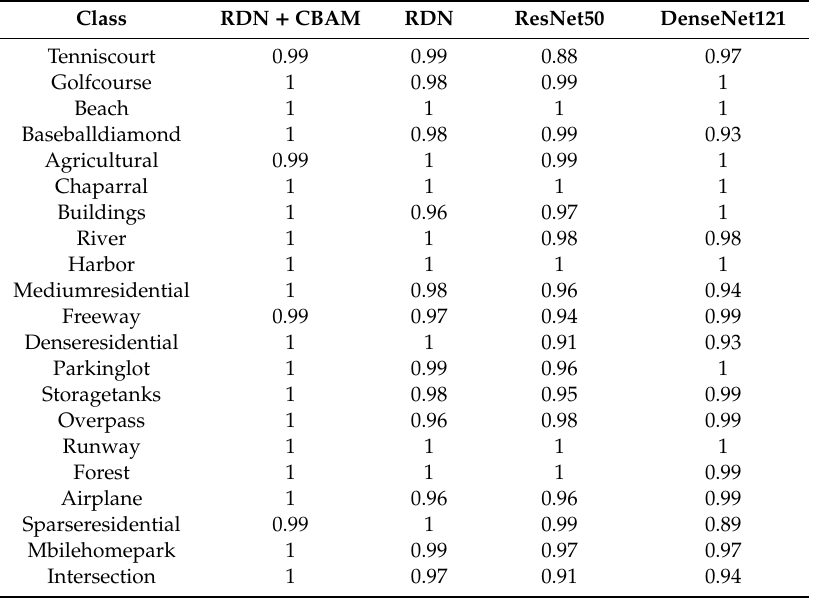
Table 3. Classification accuracy in each category of RDN + CBAM, RDN, ResNet50, DenseNet121 on the UCM dataset.